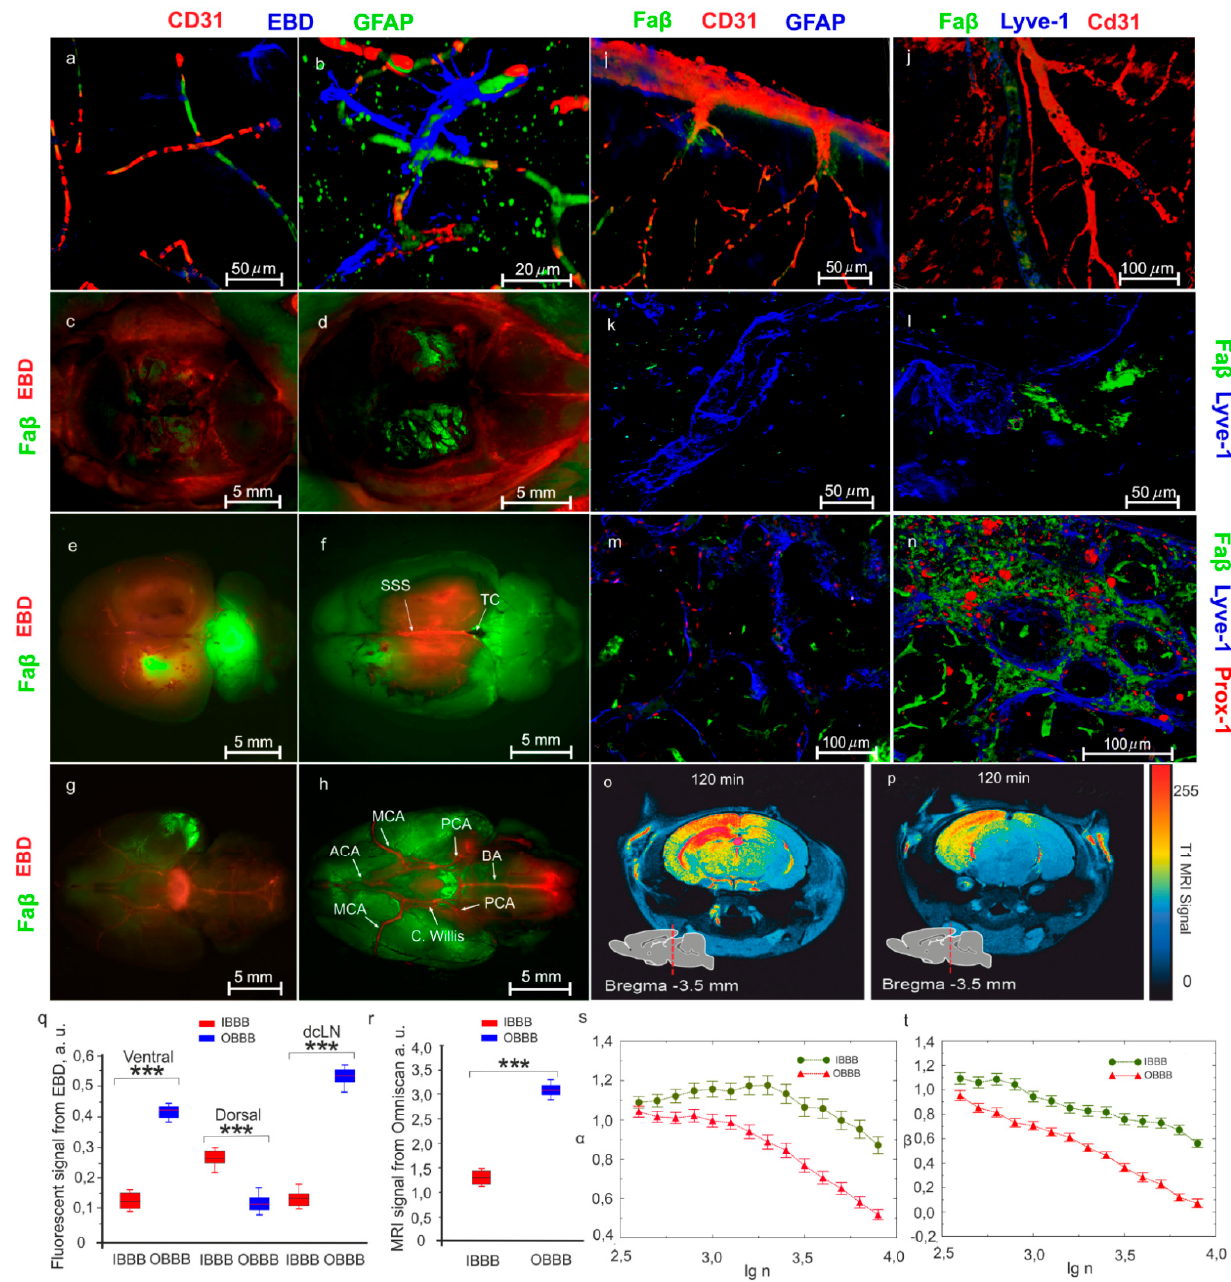
Figure 1. Music-induced OBBB affects the clearance of tracers from the mouse brain and the EEG structure : ( a , b ) Representative images of IBBB ( a ) and OBBB ( b ). In mice with IBBB, FITC-dextran is present in the cerebral vessels, while in mice with OBBB, the tracer is extravasated from the blood vessels and is distributed among the cerebral microvasculature and astrocytes. ( c , d ) Representative images of real time fluorescence imaging of fast distribution of Fa β over the surface of the brain of mice with IBBB ( c ) and OBBB ( d ) immediately after injection of Fa β in the right later ventricle. ( e – h ) Representative images of ex vivo fluorescence microscopy of delay distribution of Fa β in the lateral and dorsal parts of the brain of mice with IBBB ( e , g ) and OBBB ( f , h ) 1 h after injection of Fa β in the right later ventricle. ( i , j ) Representative images of Fa β distribution along the cerebral vessels in the pia matter ( i ) and in the meninges ( j ) in mice with OBBB. ( k , l ) Representative images of Fa β spreading in the meninges of mice with IBBB ( k ) and OBBB ( l ). ( m , n ) Representative images of presence of Fa β in dcLNs of mice with IBBB ( m ) and OBBB ( n ). ( o , p ) Representative images of MRI analysis of Omniscan distribution over the brain 2 h after its injection in the cortex of mice with IBBB ( o ) and OBBB ( p ). ( q , r ) Quantitative analysis of intensity of fluorescent signal from Fa β in a.u. on the ventral and dorsal aspects of the brain and in dcLNs in mice